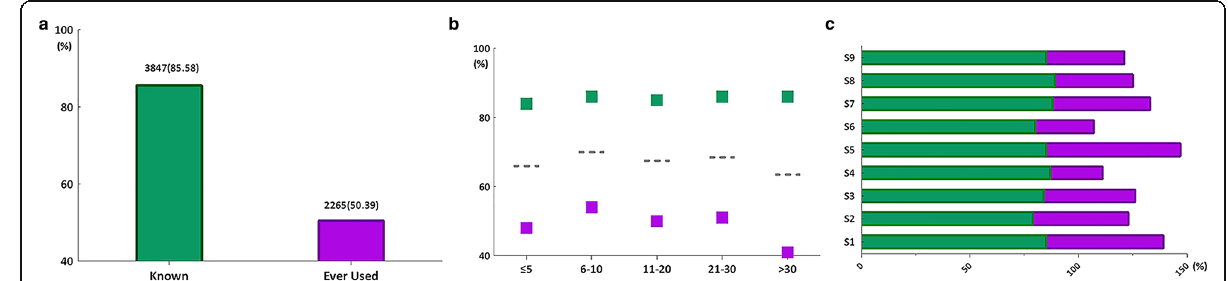
Fig. 2 General attitude towards clinical practice guidelines for traditional Chinese medicine. a Known in green means the participant was familiarized with contents of clinical practice guidelines (CPGs) for traditional Chinese medicine (CM). Ever used in purple, means the participant used CPGs in his/her clinical practice. b The two columns of the figure show the total number and percentage of CM doctors known (column 1) and the number and percentage of reported ever used CPGs (column 2); c Views of CM doctors on CPGs by nine specialties. S1: Internal medicine; S2: Oncology; S3: Surgery; S4: Gynaecology; S5: Paediatrics; S6: Ophthalmology; S7: Otolaryngology; S8: Anorectal; S9: